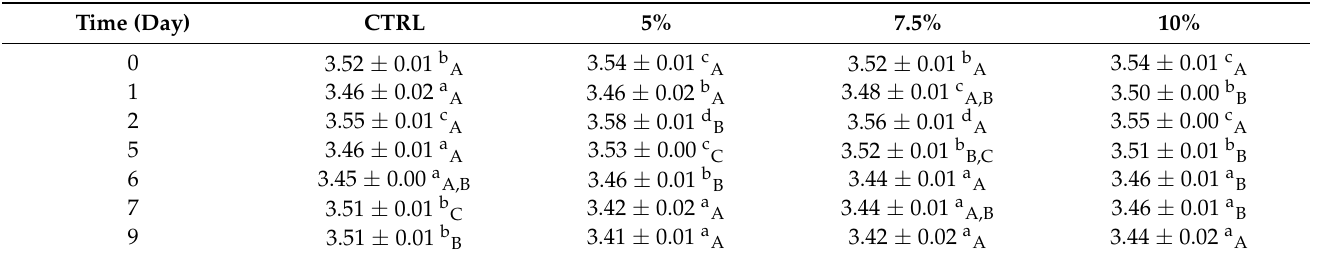
Table 4. Values of pH for apple juice inoculated with A. acidoterrestris , with and without